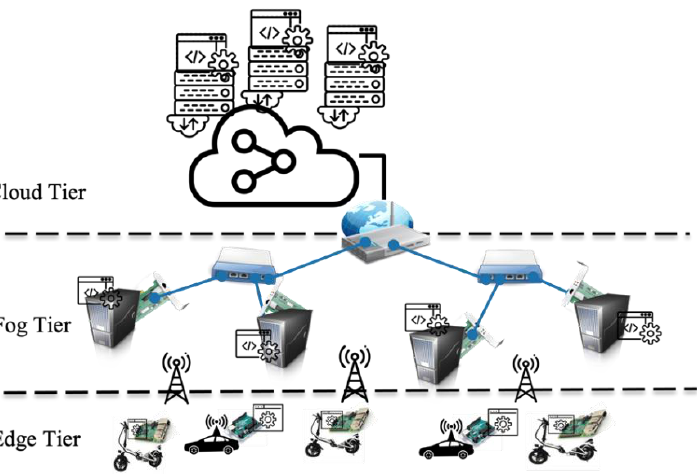
Figure 1. The 3-Tier Computing Model.